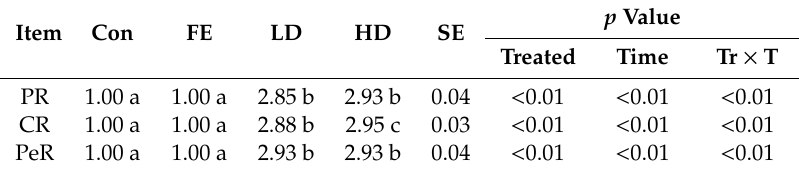
Table 1. The general monitoring results of Sprague Dawley (SD) rats anesthetized by emulsified isoflurane